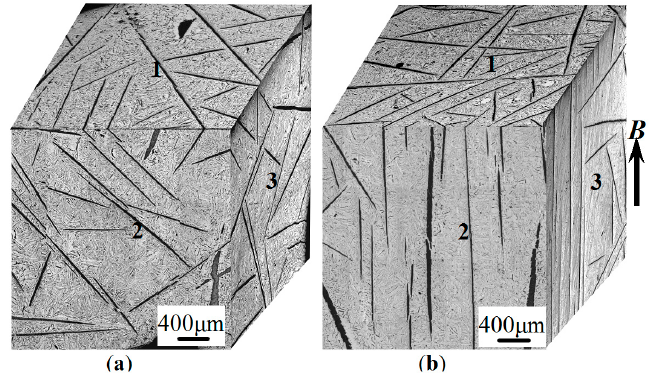
Figure 5. Microstructures of the cubes cut from the 0 and 12 T specimens. 1, 2, and 3 indicate the different surfaces of the cubes. The arrow indicates the direction of B .